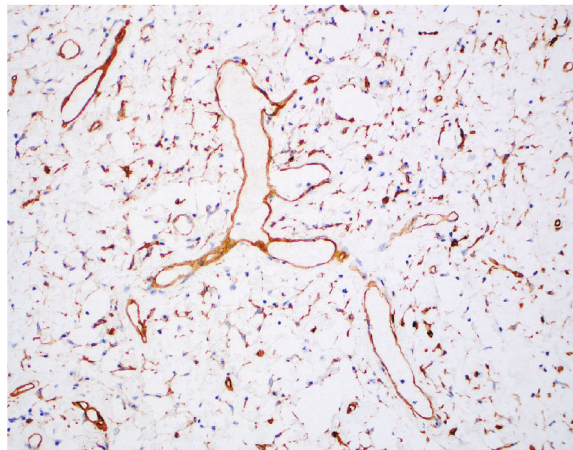
Figure 6: CD34 stain marking the cytoplasm of the stellate and spindle cells as well as a staghorn vessel at 200 magni fi cation